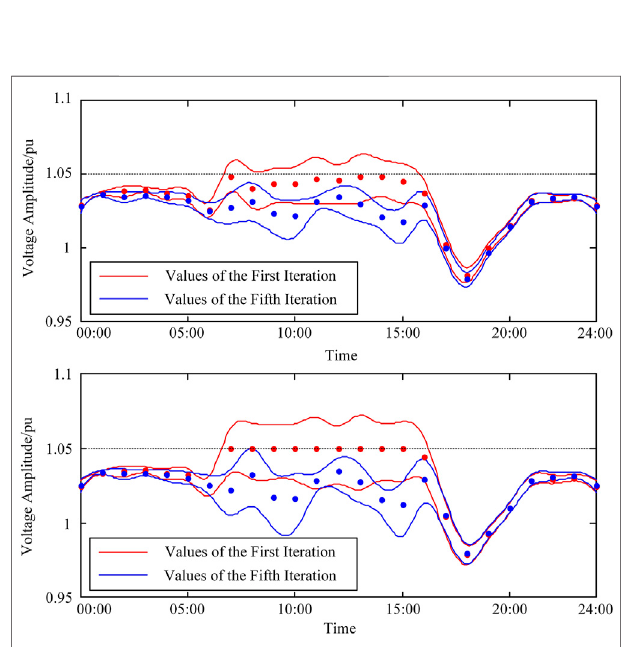
FIGURE12| Probabilityintervalsofthe fi rstiterationandthe fi fthiteration all day of nodes 10 and 17.